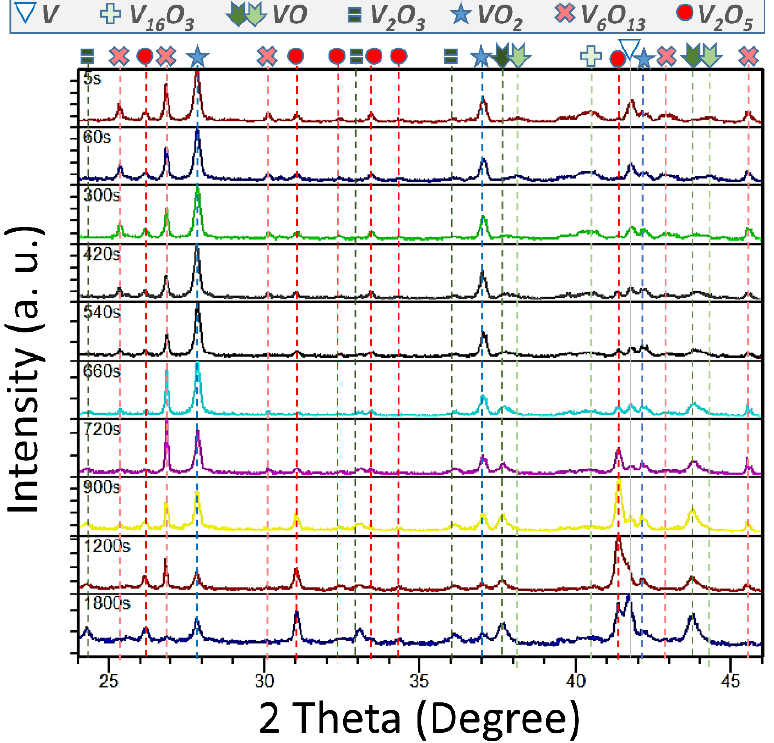
Figure 1. XRD diffractograms for samples obtained after 1-cycle thermal treatments of V nano- powder subjected to 725 °C for different reaction times (labeled in every plot) and fixed heating and cooling rates of 42 °C s − 1 and 0.05 °C s − 1 , respectively.